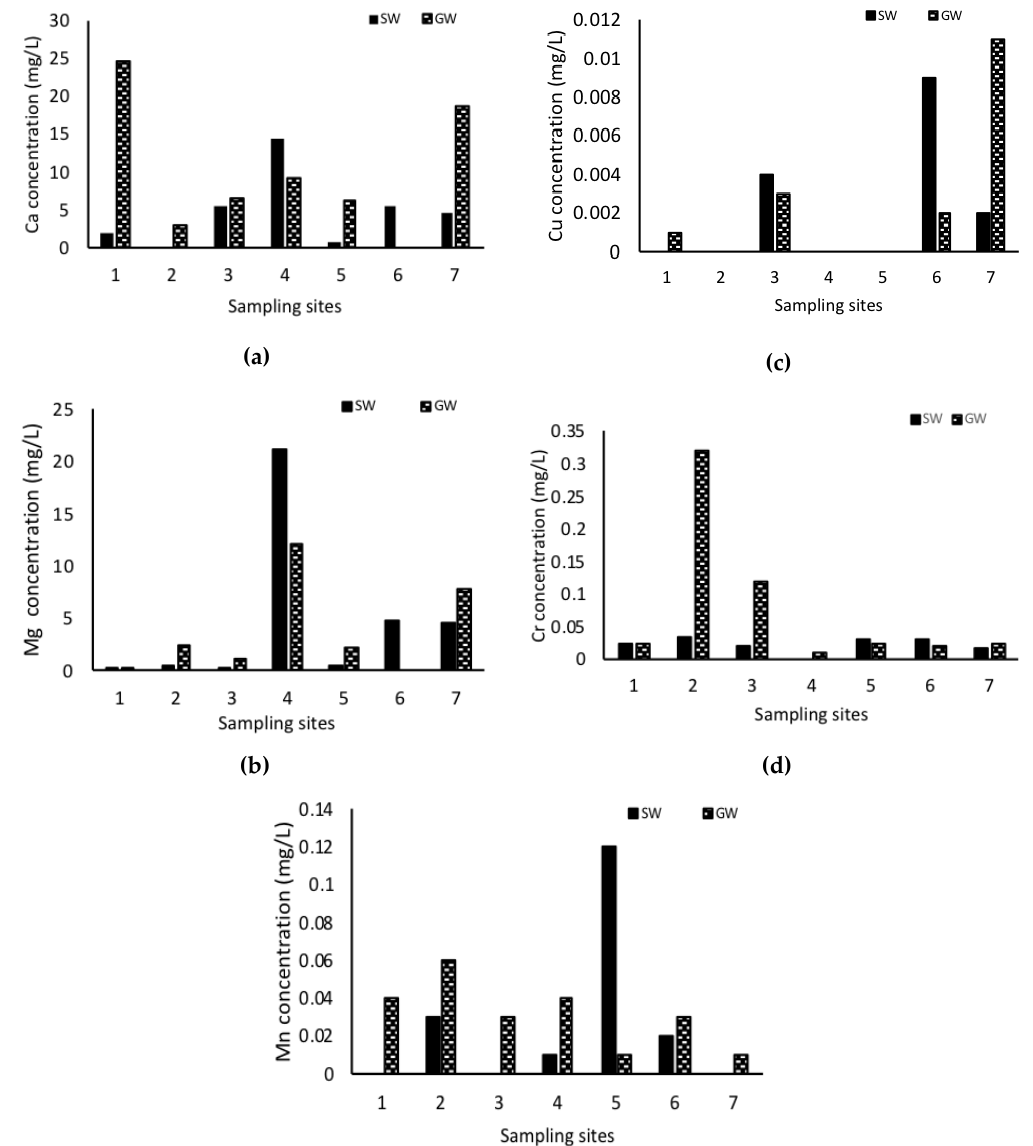
Figure 3. The levels of Ca ( a ), Mg ( b ), Cu ( c ), Cr ( d ) and Mn ( e ) determined in the ground water (GW) and surface water (SW) sources in the study area. Empty bars represent the results that were below the detection limit.